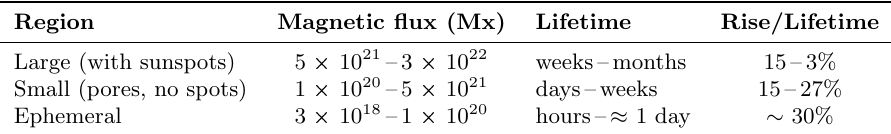
Table 1: Typical magnetic fluxes (half of total unsigned flux), lifetimes and the relative length of rise time to lifetime of bipolar ARs Region Magnetic flux (Mx) Lifetime Rise/Lifetime Large (with sunspots) 5 (cid:214) 10 21 – 3 (cid:214) 10 22 weeks – months 15 – 3% Small (pores, no spots) 1 (cid:214) 10 20 – 5 (cid:214) 10 21 days – weeks 15 – 27% Ephemeral 3 (cid:214) 10 18 – 1 (cid:214) 10 20 hours – ≈ 1 day ∼